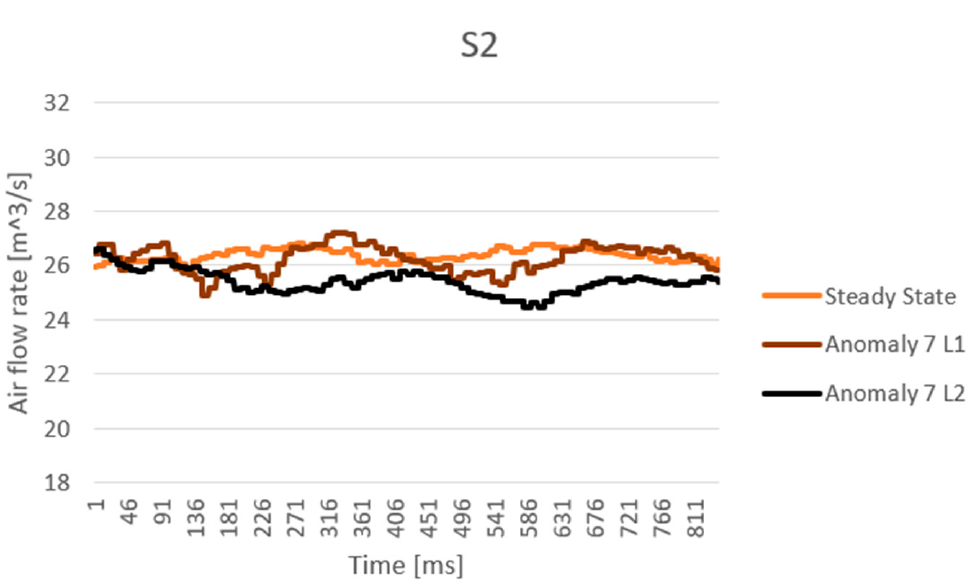
Figure 18. Outlet air flow rate of steady state, anomaly 9 level 1 and 2 samples. The two figures attest that the trend of the anomalous air system is very similar to the trend of the steady state under both circumstances. In conclusion, despite the low-precision results, the algorithm can still evaluate sys- tem conditions. The created model can classify the presence or absence of an anomaly. For example, suppose there is a significant occlusion in the system pipelines. In that case, the algorithm can identify and classify it, but if there is only a minor occlusion, the model can only notify the problem. 4.7. Summary Self-Organizing Maps are generally used to solve clustering problems such as image classification [53] or customer segmentation in the economic-financial domain [54]. In the case of this study, the SOM algorithm is applied to anomaly detection instead. The